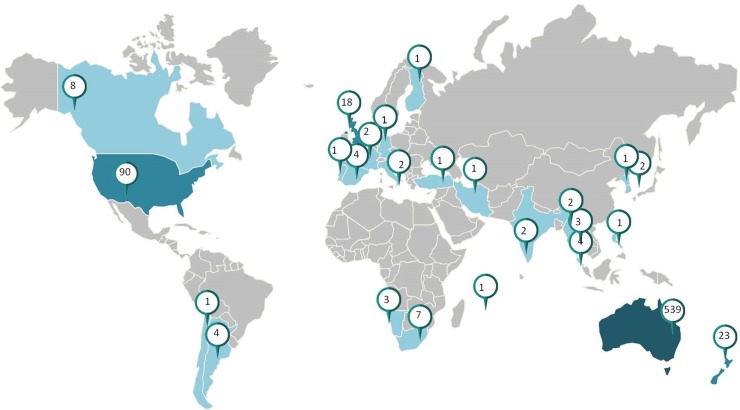
Geographical distribution of respondents.